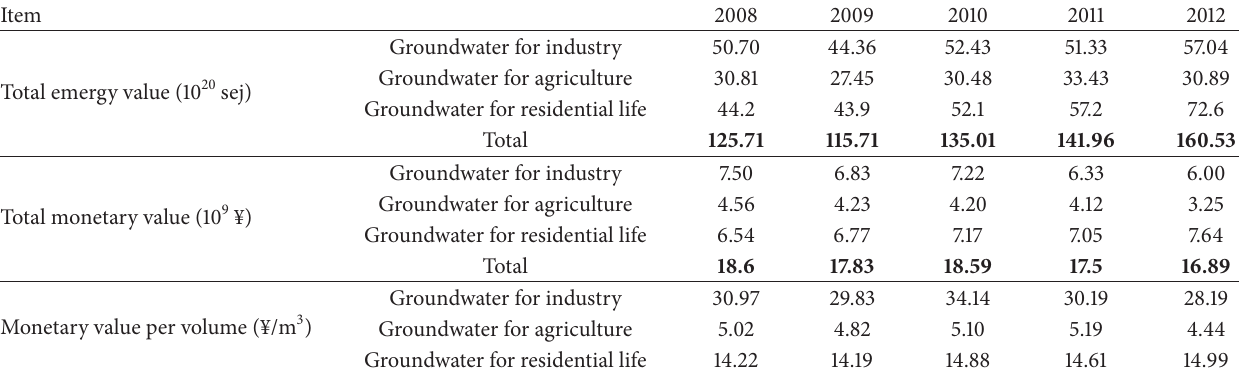
Table 6: The summary table of Beijing groundwater value.